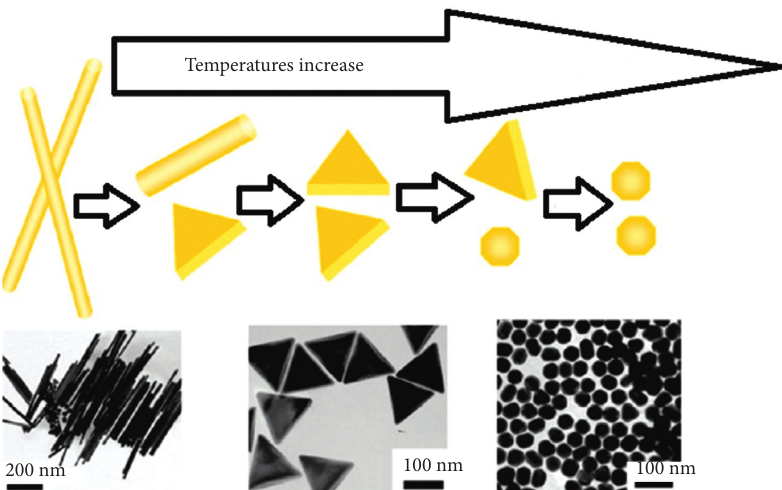
Figure 4: Scheme of gold nanostructures with different morphologies formed at different temperatures along with transmission electron microscope images related to them